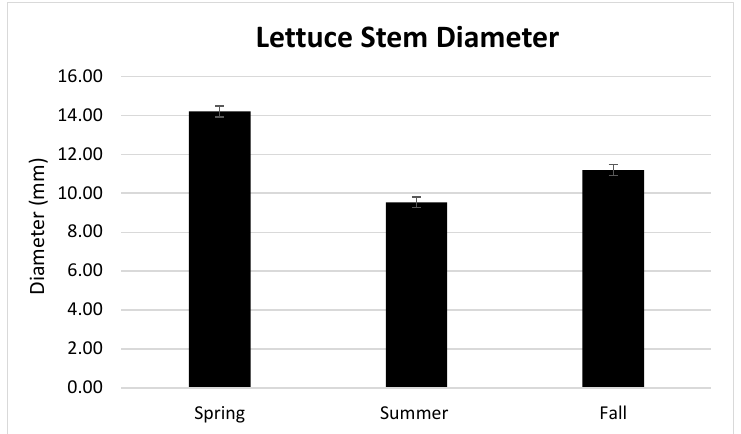
Figure 2. The effect of growing season on lettuce stem diameter. The standard error of the mean was: stem diameter ± 0.28.